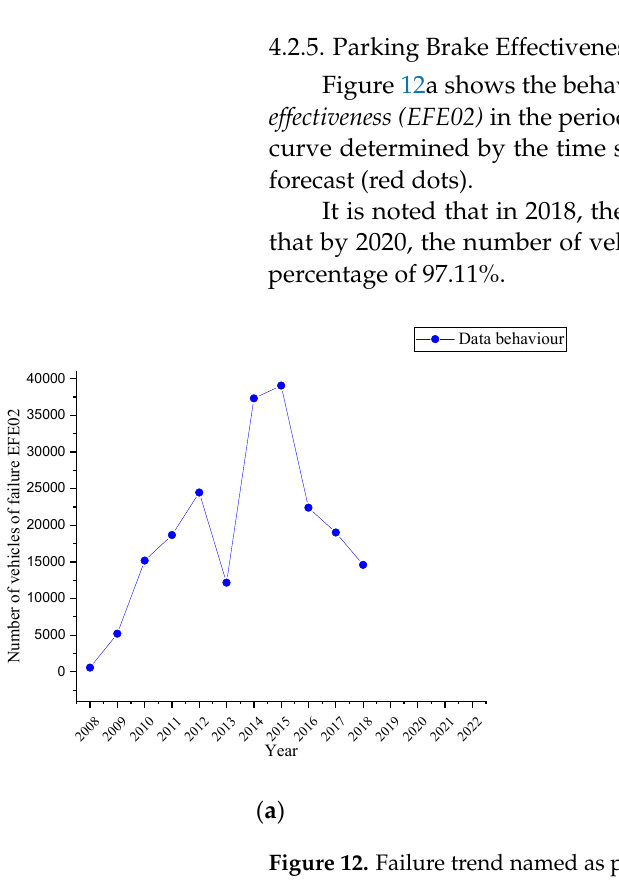
Figure 11. Failure trend named as insufficient tyre tread (ILN02). ( a ): Behaviour of the failure (blue line); ( b ): the time series with a quadratic trend (red line) and the forecast (red dots).